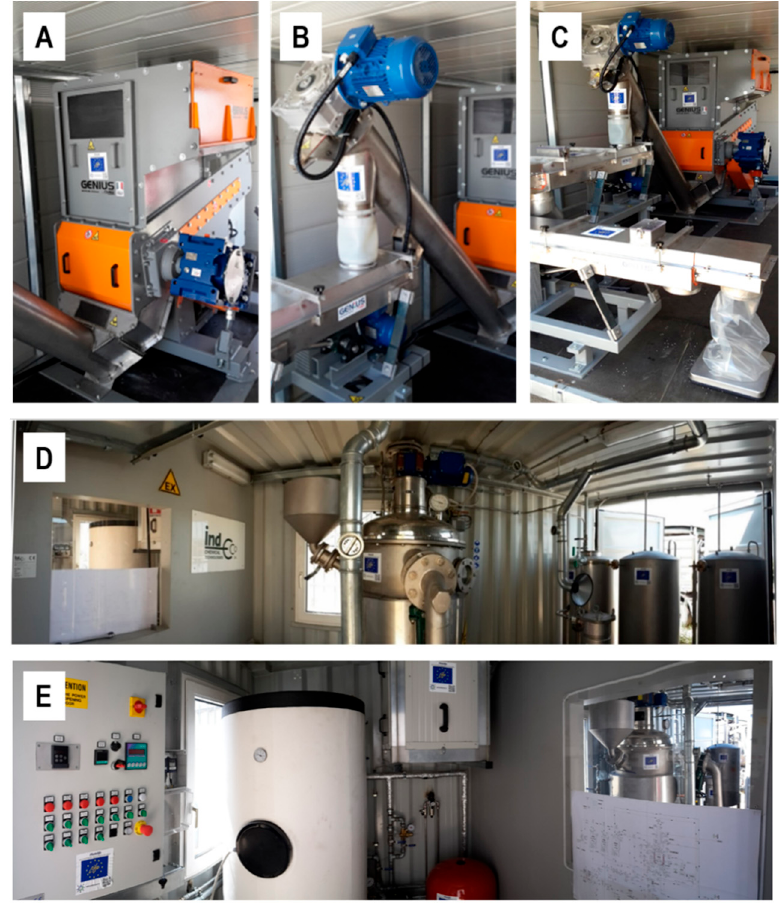
Figure 2. PhotoLife prototypes: container 1 with crusher ( A ) and vibrosieving ( B , C ); Container 2 with reactor for solvent treatment and gravimetric separation ( D ), and control cabin ( E ).